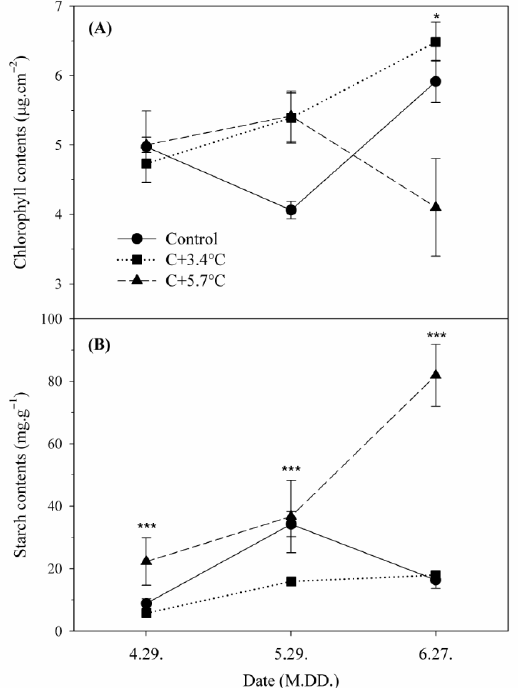
Figure 4. Changes in chlorophyll ( A ) and starch contents ( B ) in the leaves of peach trees grown under different temperatures and a carbon dioxide concentration of 700 μ mol·mol − 1 during the 2019 growing season. The solid circle, square and triangle represent control, C+3.4 °C and C+5.7 °C re- spectively. Vertical bars represent the standard error of means from three replications. The asterisks * and *** indicate significant differences at p ≤ 0.05 and p ≤ 0.001, respectively.